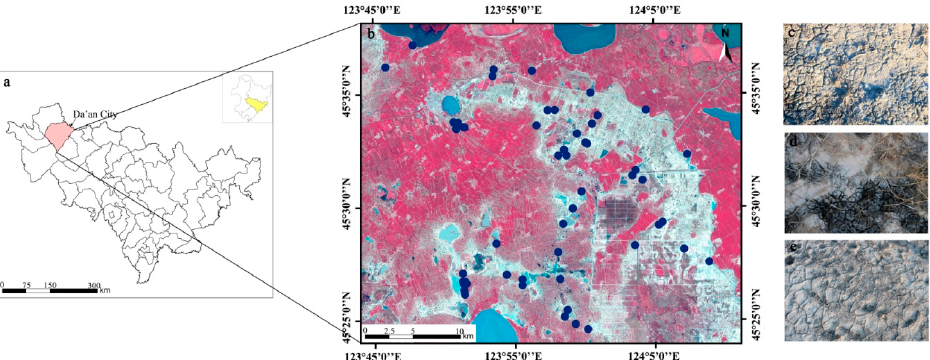
Figure 1. The study area and distributions of sampling points. ( a ) The study area location, ( b ) the soil sampling locations, ( c – e ) the cracked soil surface under natural conditions.